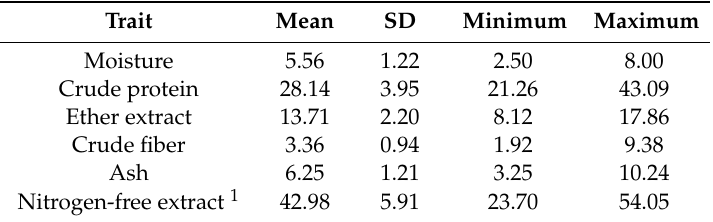
Table 1. Classification by main protein source of the commercial extruded dry food samples for dogs included in the study. Group Main Protein Sources Other Ingredients Number of Samples Red meat Pork, lamb, horse, venison Eggs, pea, rice, potato 37 Only fish Potato, rice 13 Chicken, pork, fish - 15 Only chicken Rice 29 White meat Rabbit, chicken, duck Eggs, potato 21 Other Not specified on the label - 4 Table 2. Chemical composition (% as fed) of extruded dry dog food samples ( n = 119) included in this study, determined using near-infrared spectroscopy, applying pre-installed commercial calibrations of FOSS for pet